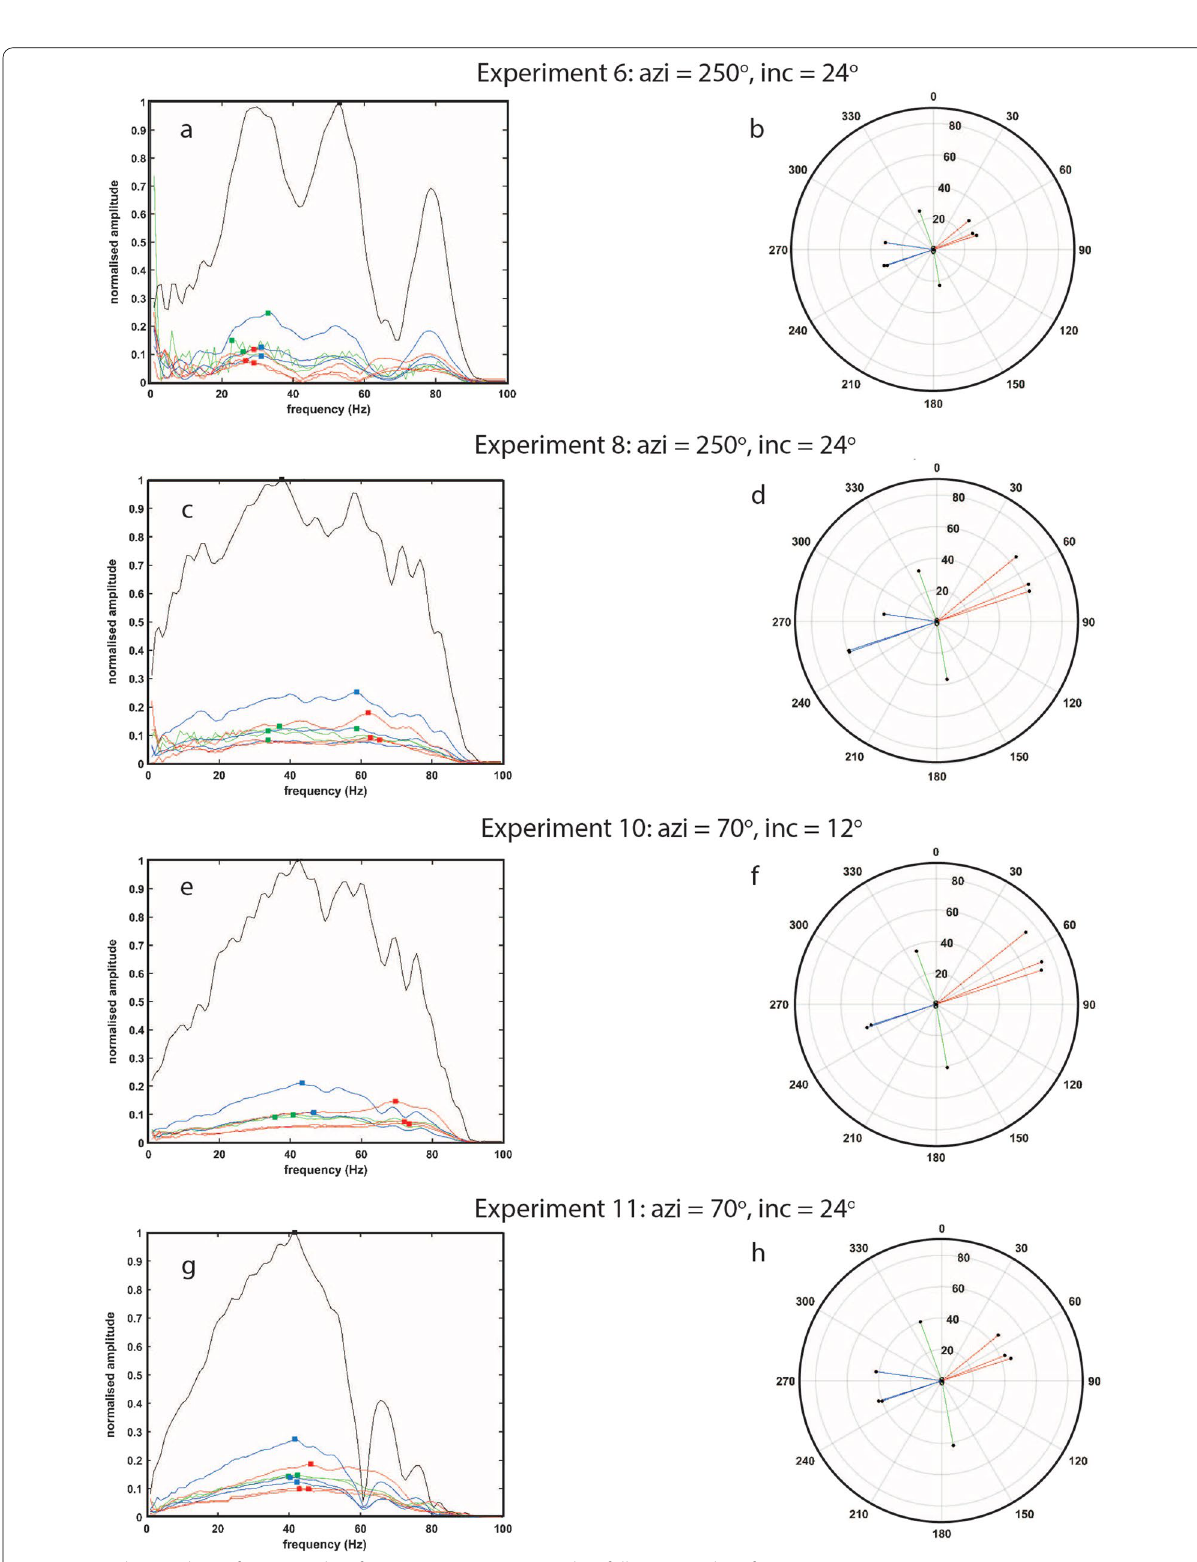
Fig. 5 Complete analysis of eruption data for experiments 6, 8, 10 and 11 following analysis from Fig.